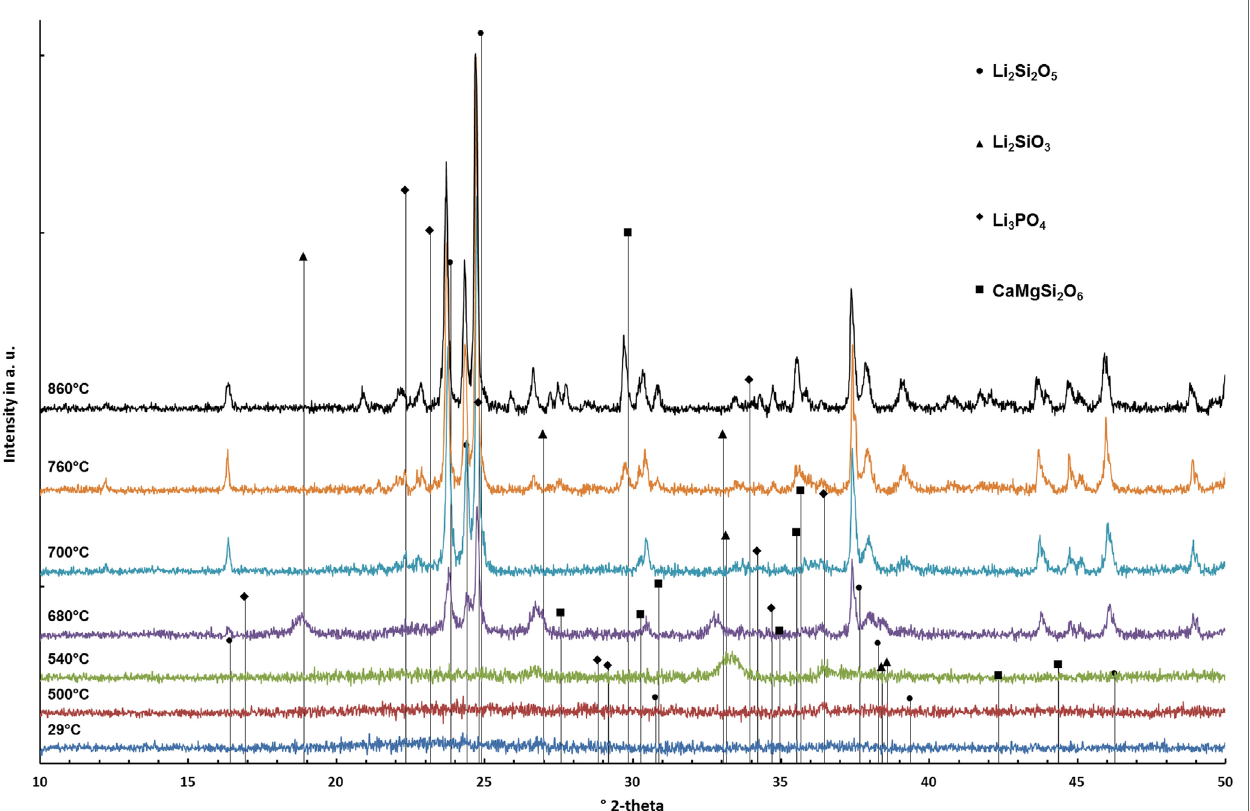
FigUre 3 | Diffractograms of glass D surveyed at different temperatures